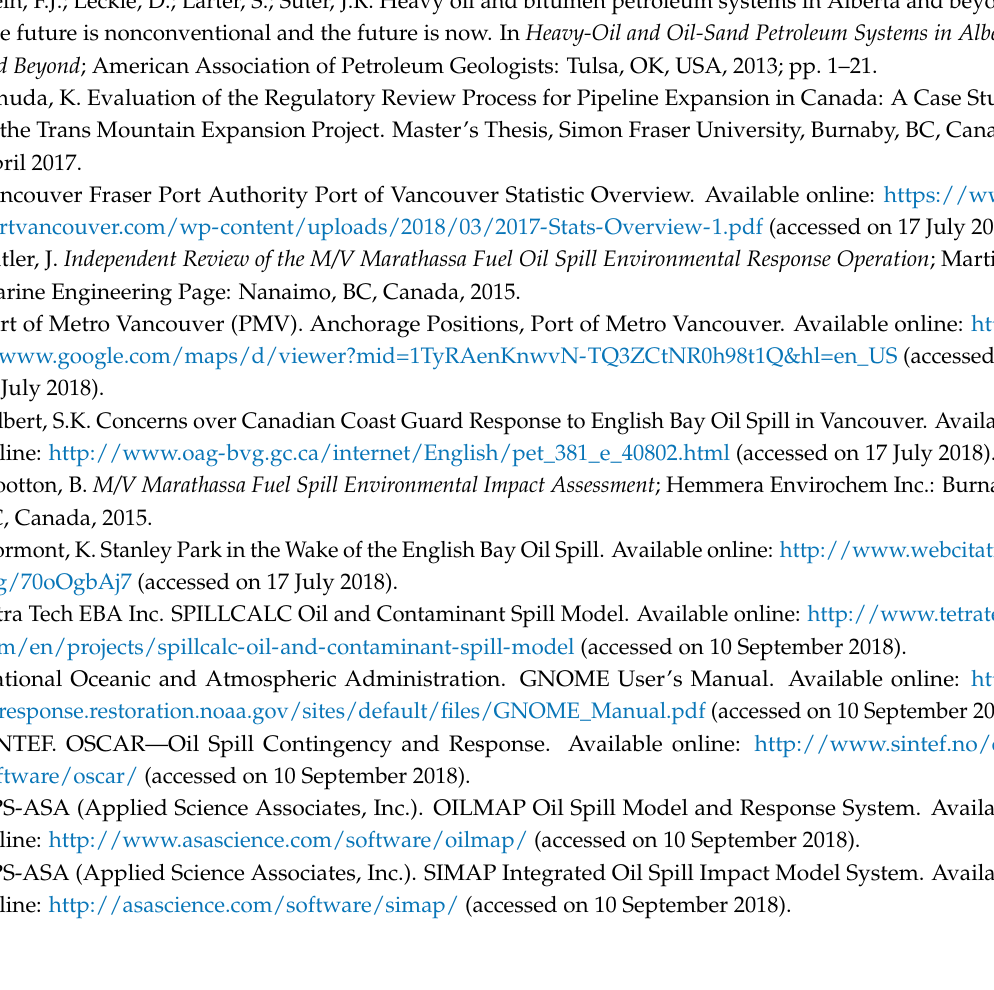
Figure S1. Example of oil trajectories for the oil spill with different oil start-releasing time. Figures from top to bottom are oil start release at (a) 12:00, (b) 13:00, (c) 14:00, (d) 15:00 and (e) 16:00; Figure S2. Example of oil trajectories for spilled oil forced without wind (top) or with winds (bottom); Figure S3. Example of oil trajectories for oil discharge instantly (top) or continuously (bottom); Figure S4. Example of oil trajectories for oil spill without (top) or with (bottom) recovery actions; Table S1. Aerial overflight surveys for the MV Marathassa oil spill; Table S2. Western Canada Marine Response Corporation’s (WCMRC) response to the spill; Table S2. The chemical composition of IFO 380 in the OSCAR model; Table S4. Assumptions for mechanical response strategies (recovery actions); Table S5. Factors’ setting in each simulation; Table S6. The influence of studied factors on the mass balance of MV Marathassa spilled oil; Table S7. Water surface contaminant comparison. The simulated results were compared with observation data; Table S8. Shoreline contaminant comparison. The simulated results were compared with observation